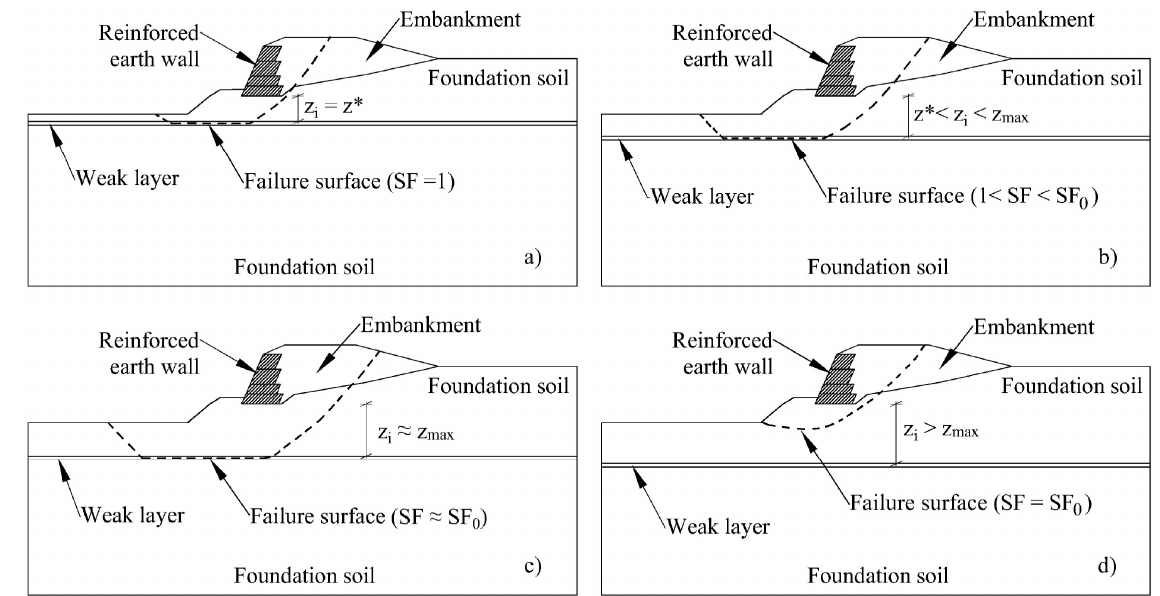
Figure 12. Significant scenario representing the failure mechanism and the stability condition of the embankment in the case of the weak layer located at different depths. The weak layer affects both the failure mechanism and the safety factor: ( a ) weak layer located at depth z i equal to the critical depth z* (SF = 1); ( b ) weak layer located at depth z i between the critical depth z* and the maximum depth z max (1 < SF < SF 0 , where SF 0 is the safety factor in case of homogenous foundation soil); ( c ) weak layer located at depth equal to the maximum depth z max (SF ≈ SF 0 ); ( d ) weak layer located at a depth higher than the maximum depth z max (SF = SF 0 ).